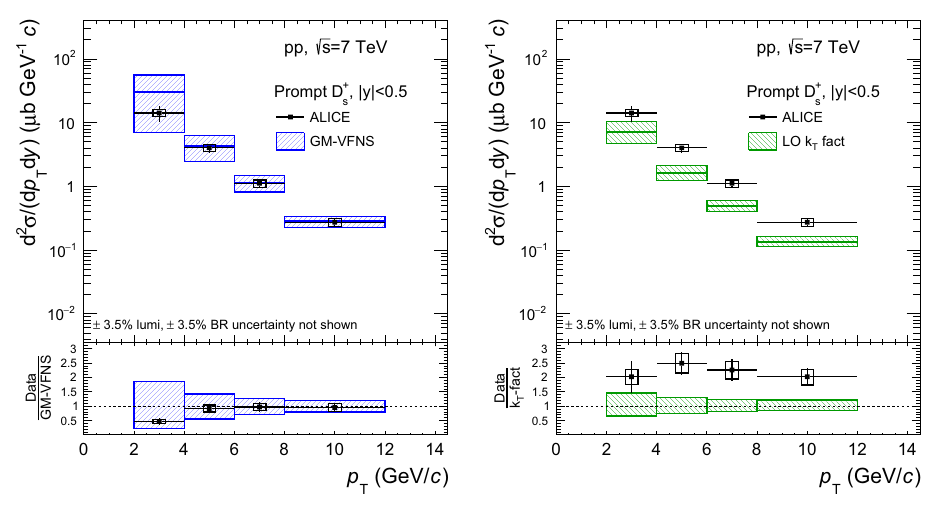
Fig. 6 p T -differential production cross section of prompt D ∗+ mesons with | y | < 0 . 5 in the interval 1 < p T < 24 GeV / c , in pp √ s = 7 TeV. The collisions at cross section is compared to three pQCD calculations: FONLL [7] ( top-left panel ), GM-VFNS [5] ( top-right panel ) and a leading order (LO) calculation based on k T -factorisation [9] ( bottom panel ). The ratios of the data to the three calculated cross sections are shown in the lower part of each panel. In the data-to-theory ratios the 3.5% normalisation uncertainty due to the luminosity determination is not included in the systematic uncertainty on the data points